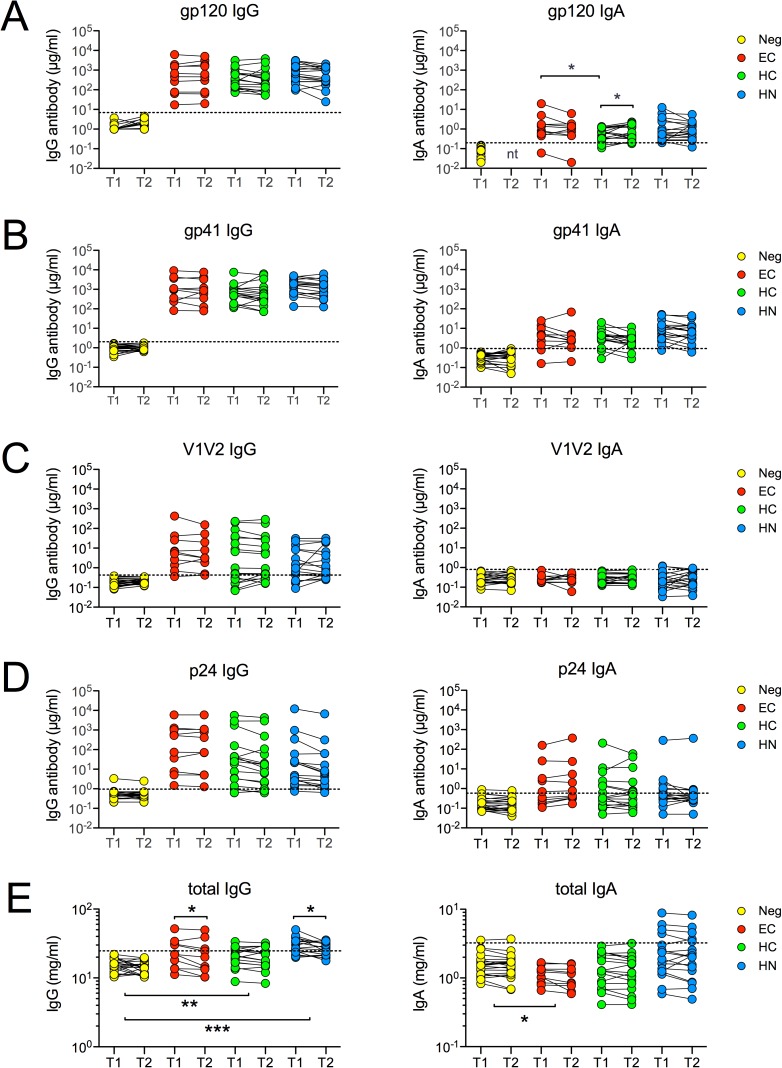
Persistence of IgA and IgG antibody concentrations.Concentrations of serum IgG and IgA antibodies to (A) gp120consensus B, (B) gp41BAL
(C) gp70-V1V2Clade B/Case A2 and (D) p24HXB2 were quantitated at T1 and T2 using ELISA. (E) Total IgG and IgA concentrations at T1 and T2 were also measured by ELISA. Dashed lines denote the cut-offs for significance, which represent the mean + 3 SD of Neg control values at both time points, or at T1 alone if T2 was not tested (nt). In every infection group, concentrations of antigen-specific IgG or IgA were significantly greater than those in Neg controls (all p < 0.05) except for V1V2-specific IgA. At T1 and T2, concentrations of total IgG in HC or HN were also greater than those in Neg. At both T1 and T2, the total IgA in EC was lower than in Neg controls. Within group comparisons at T1 and T2 were done using the Wilcoxon matched pairs test. Between group comparisons at matched time points were performed using Mann-Whitney rank sum test. *p < 0.05; **p < 0.01; ***p < 0.001.